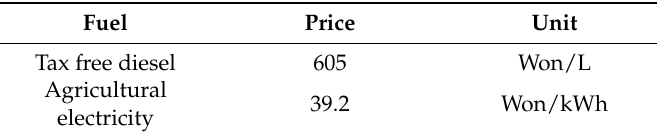
Table 8. Operation costs of each energy